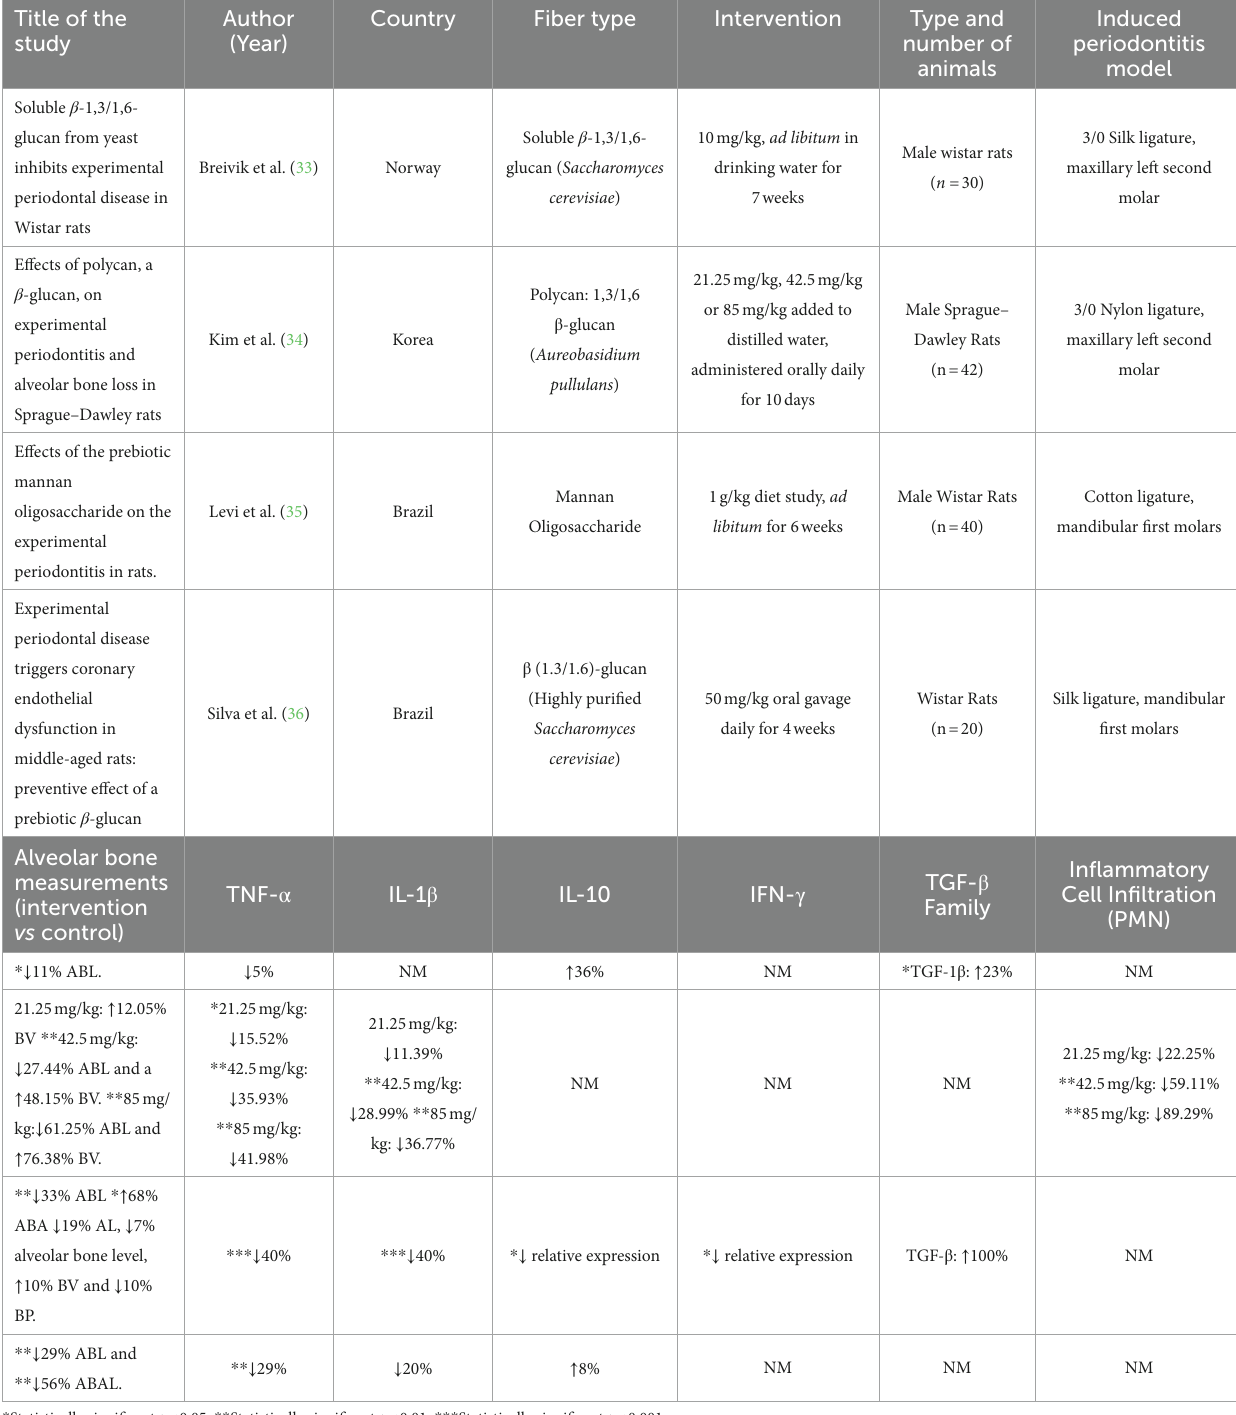
TABLE 1 Study characteristics, clinical periodontal parameters and selected inflammatory markers in four included